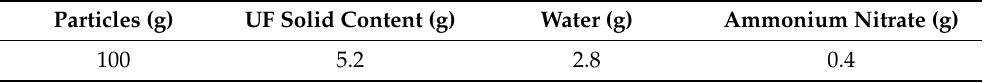
Table 1. Ratio of particles to adhesive mass of the experimental panels.